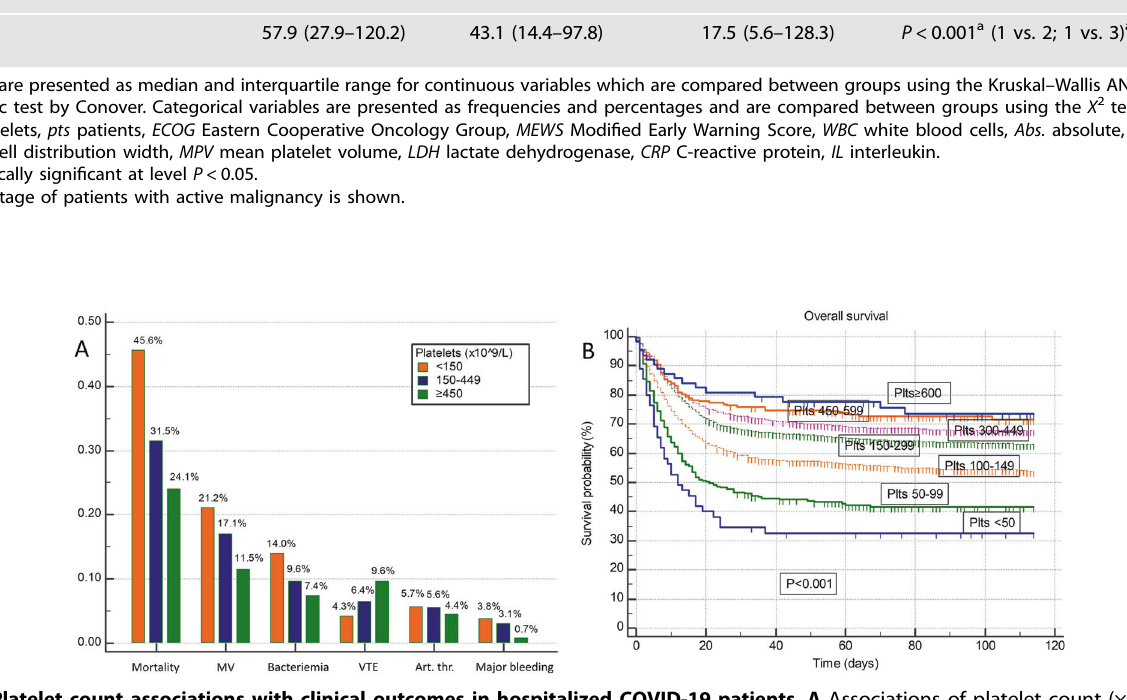
Fig. 1 Platelet count associations with clinical outcomes in hospitalized COVID-19 patients. A Associations of platelet count (×10 9 /L) on admission with in-hospital mortality, mechanical ventilation (MV), bacteriemia, venous thromboembolism (VTE), arterial thrombosis and major bleeding. B Overall survival strati fi ed by platelet count on